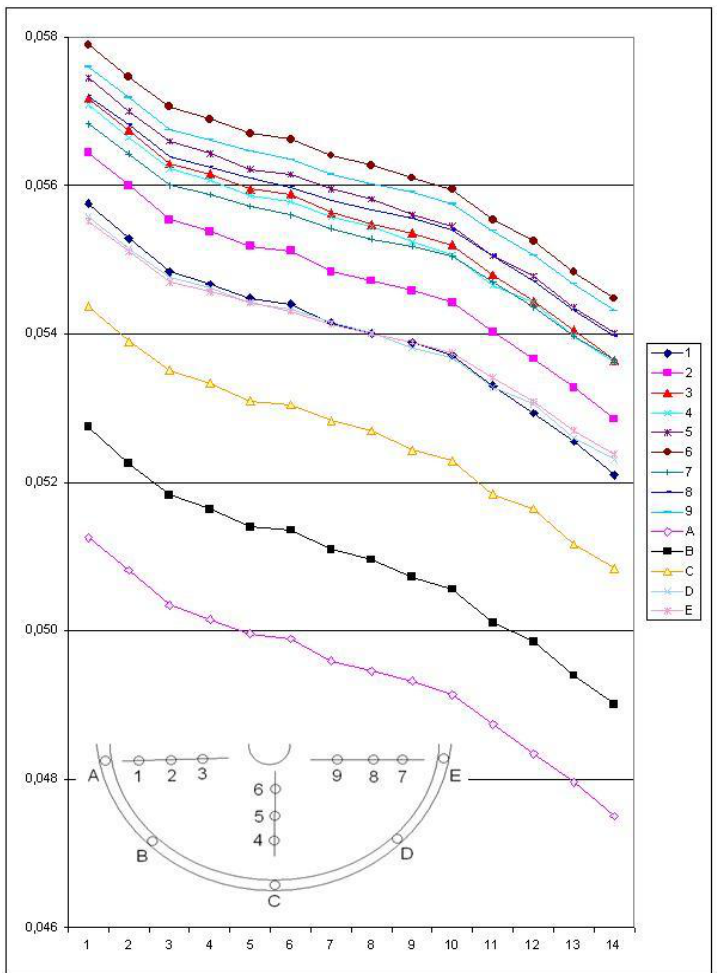
Figure 11. Vertical displacements (at different epochs) measured with the image-based method.